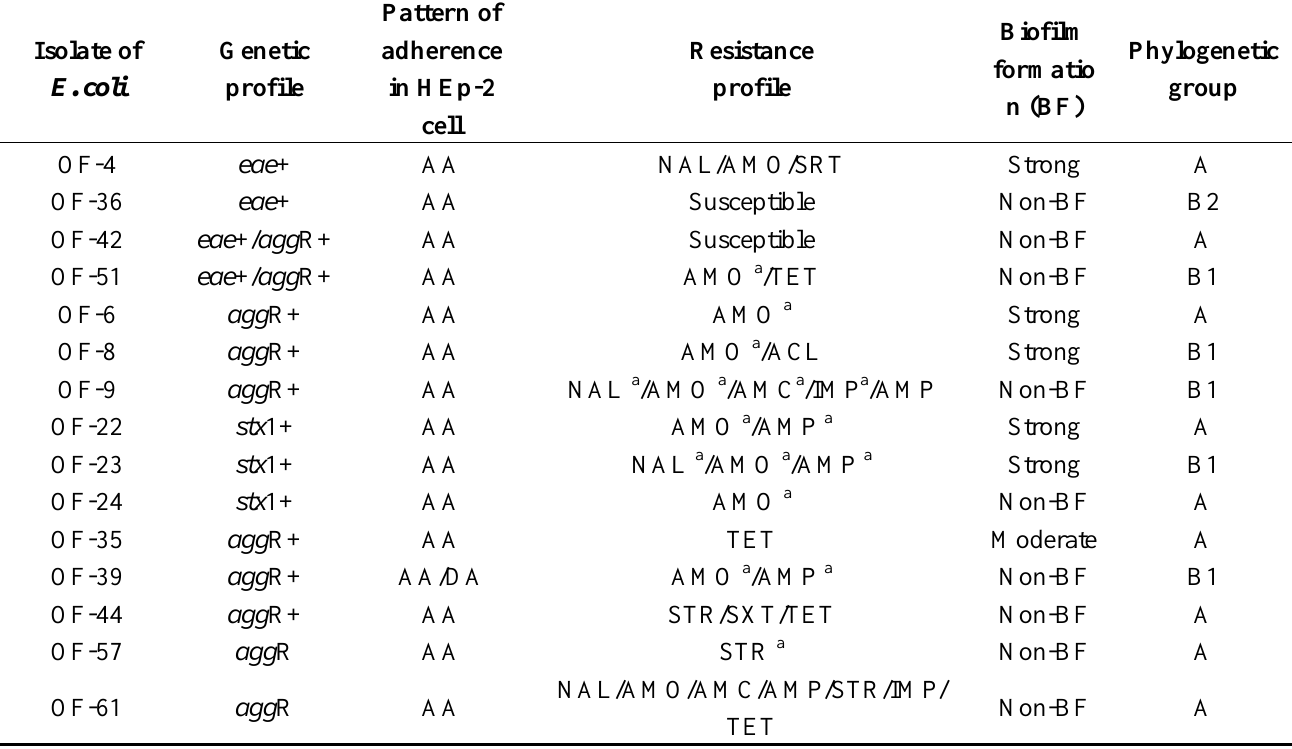
Table 2. Genotypic and phenotypic analysis of diarrheagenic E. coli isolates collected from organic fertilizer